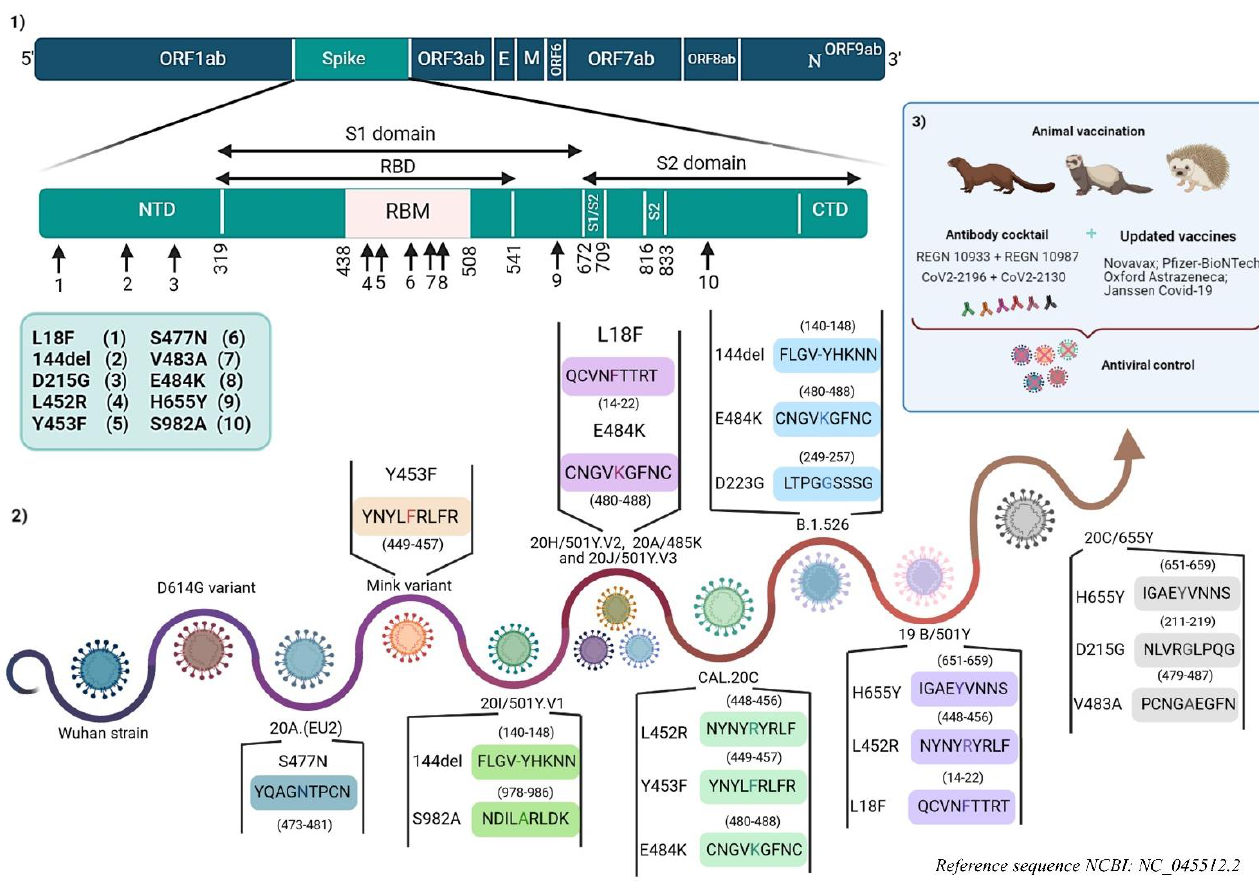
Figure 2. The history of SARS-CoV-2 and its variants subject to vaccine immunity and neutralization by monoclonal antibodies. ( 1 ) The localization of immune escape mutations in the SARS-CoV-2 genome. ( 2 ) Emerging variant mutations involved in vaccine immunity escape and/or monoclonal antibody neutralization escape. ( 3 ) Measures taken to control variants and the potential emergence of others. (Designed by biorender) .